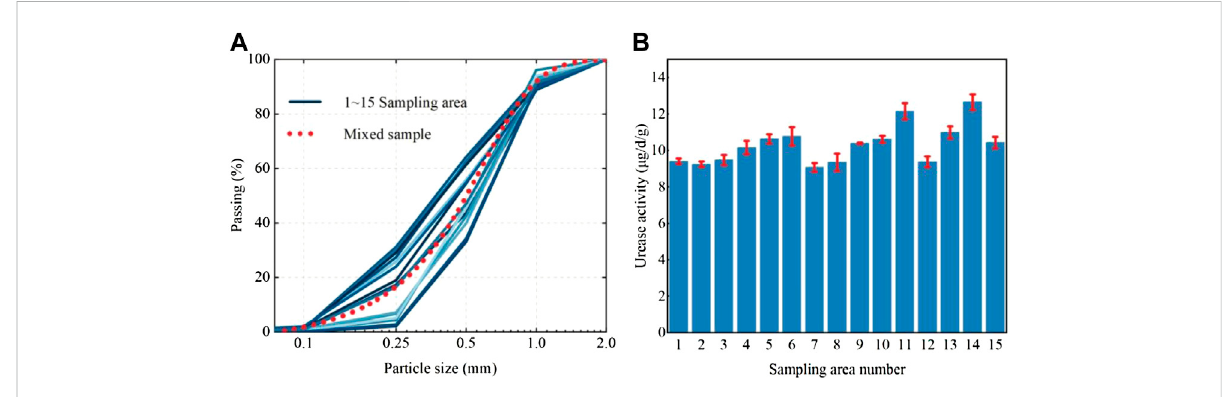
FIGURE 2 Particle size distribution curve (A) and urease activity (B) of